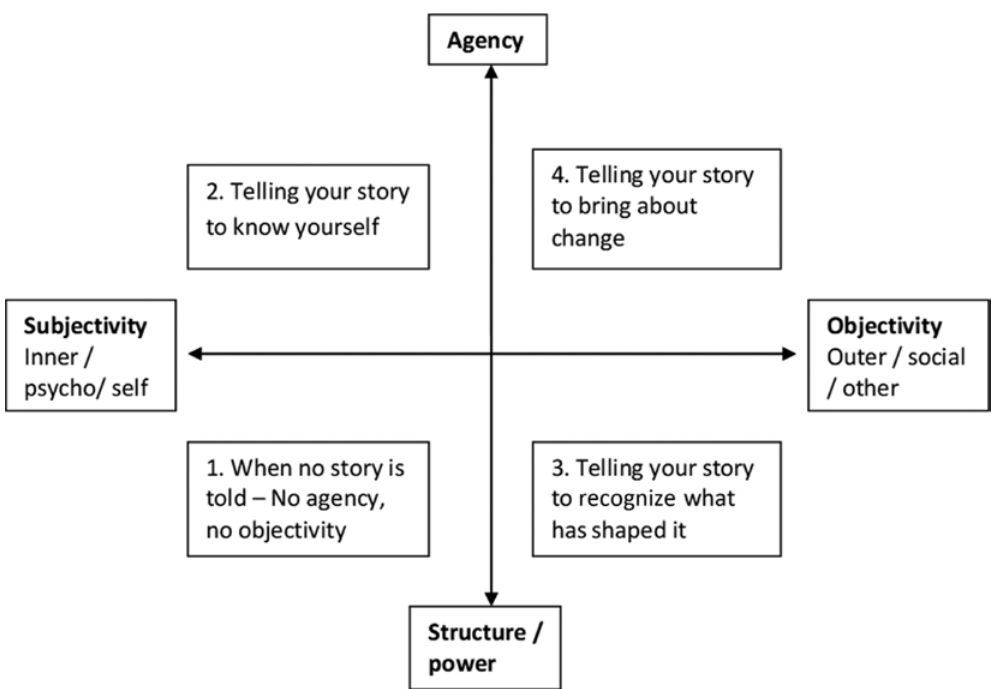
Figure 1: A model of binary dimensions of narrative practice (Source: Author,